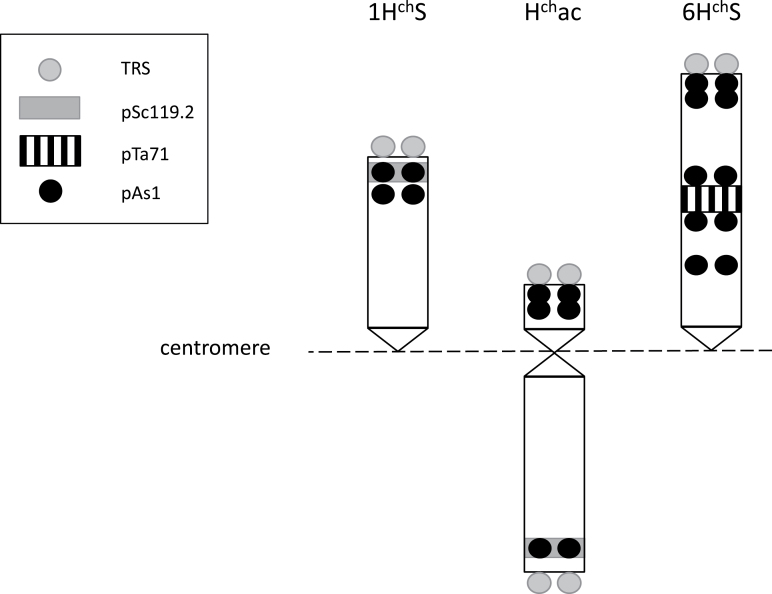
Graphical representation showing the locations of telomere repeat sequences (TRS), pSc119.2, pTa71 rDNA, and pAs1 repetitive probes in 1HchS, 6HchS, and the acrocentric chromosome Hchac.